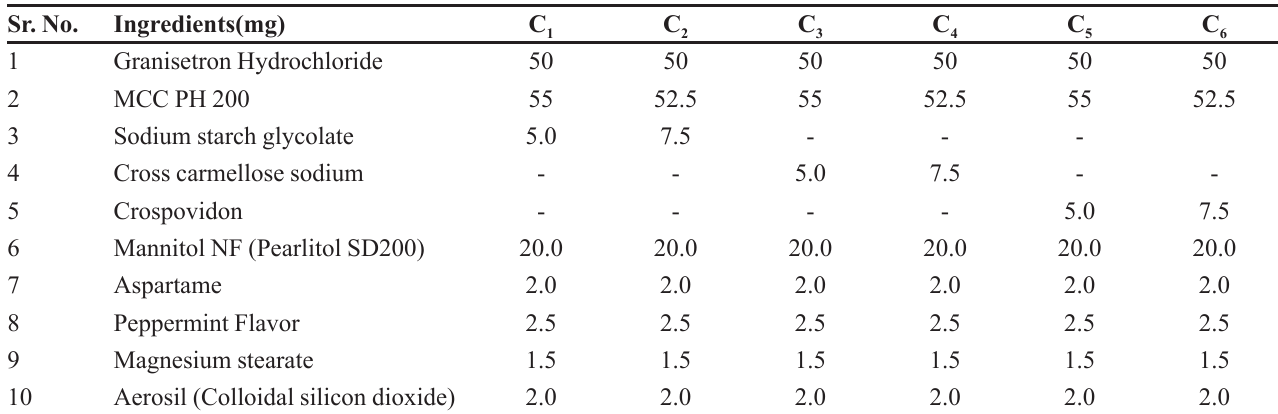
TABLE I - Compositions of orally dispersible tablet (138 mg) Sr.